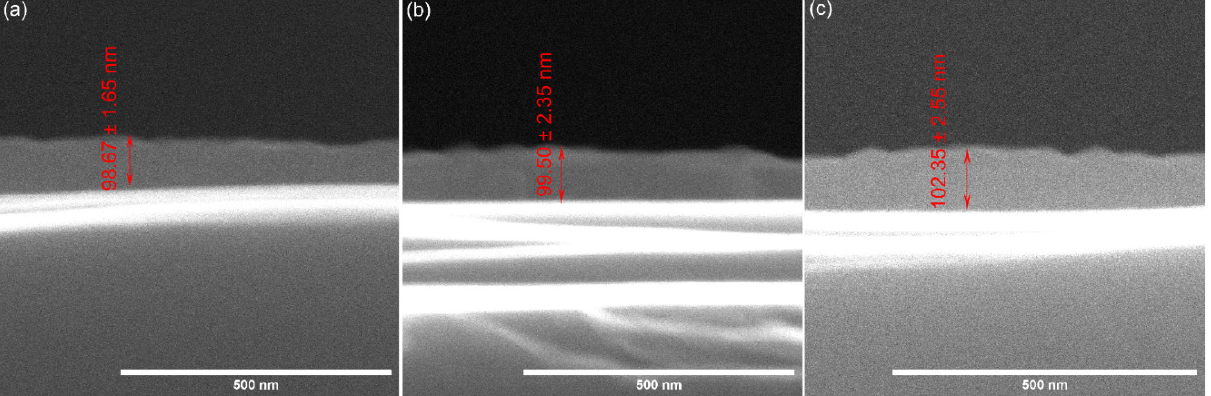
Figure 6. SEM images of transversal cross section of 10 MgHApCh-0 ( a ), 10 MgHApCh-3 ( b ), and 10 MgHApCh-6 ( c ) thin films.